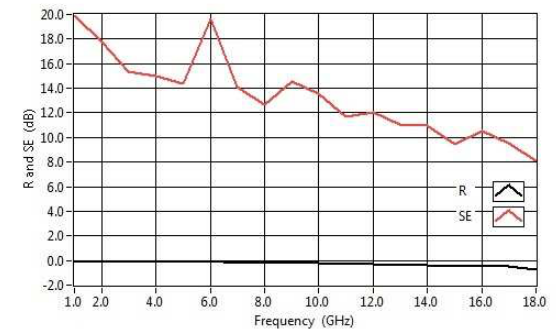
Figure 8: Reflectivity (black line) and SE (red line) vs. frequency of a 1 mm side dimension mesh grid.